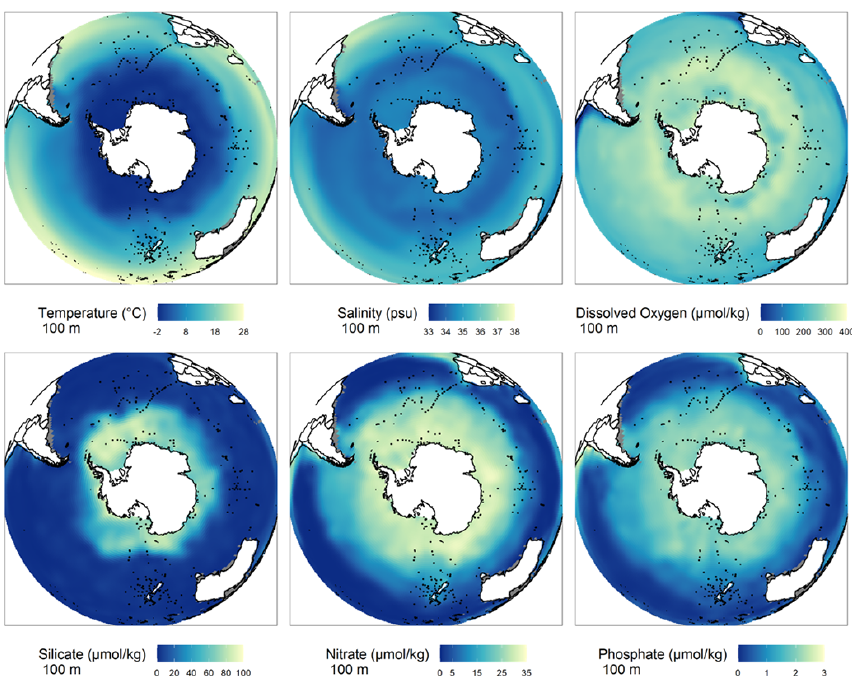
Figure 2. Locations of sites (black dots) and the six environmental variables at 100m water depth used to demonstrate the environmental coverage of the SO-RAD dataset (data source: Locarnini et al., 2018; Garcia et al., 2019a, b; Zweng et al., 2019).